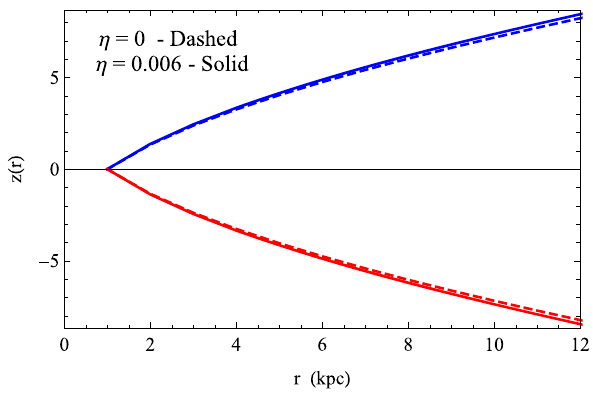
Fig. 13 The embedding diagram of z ( r )